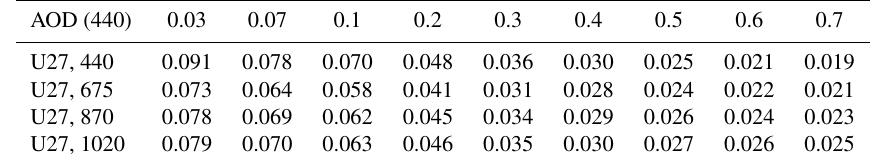
Table 17. Average SSA uncertainties estimated at